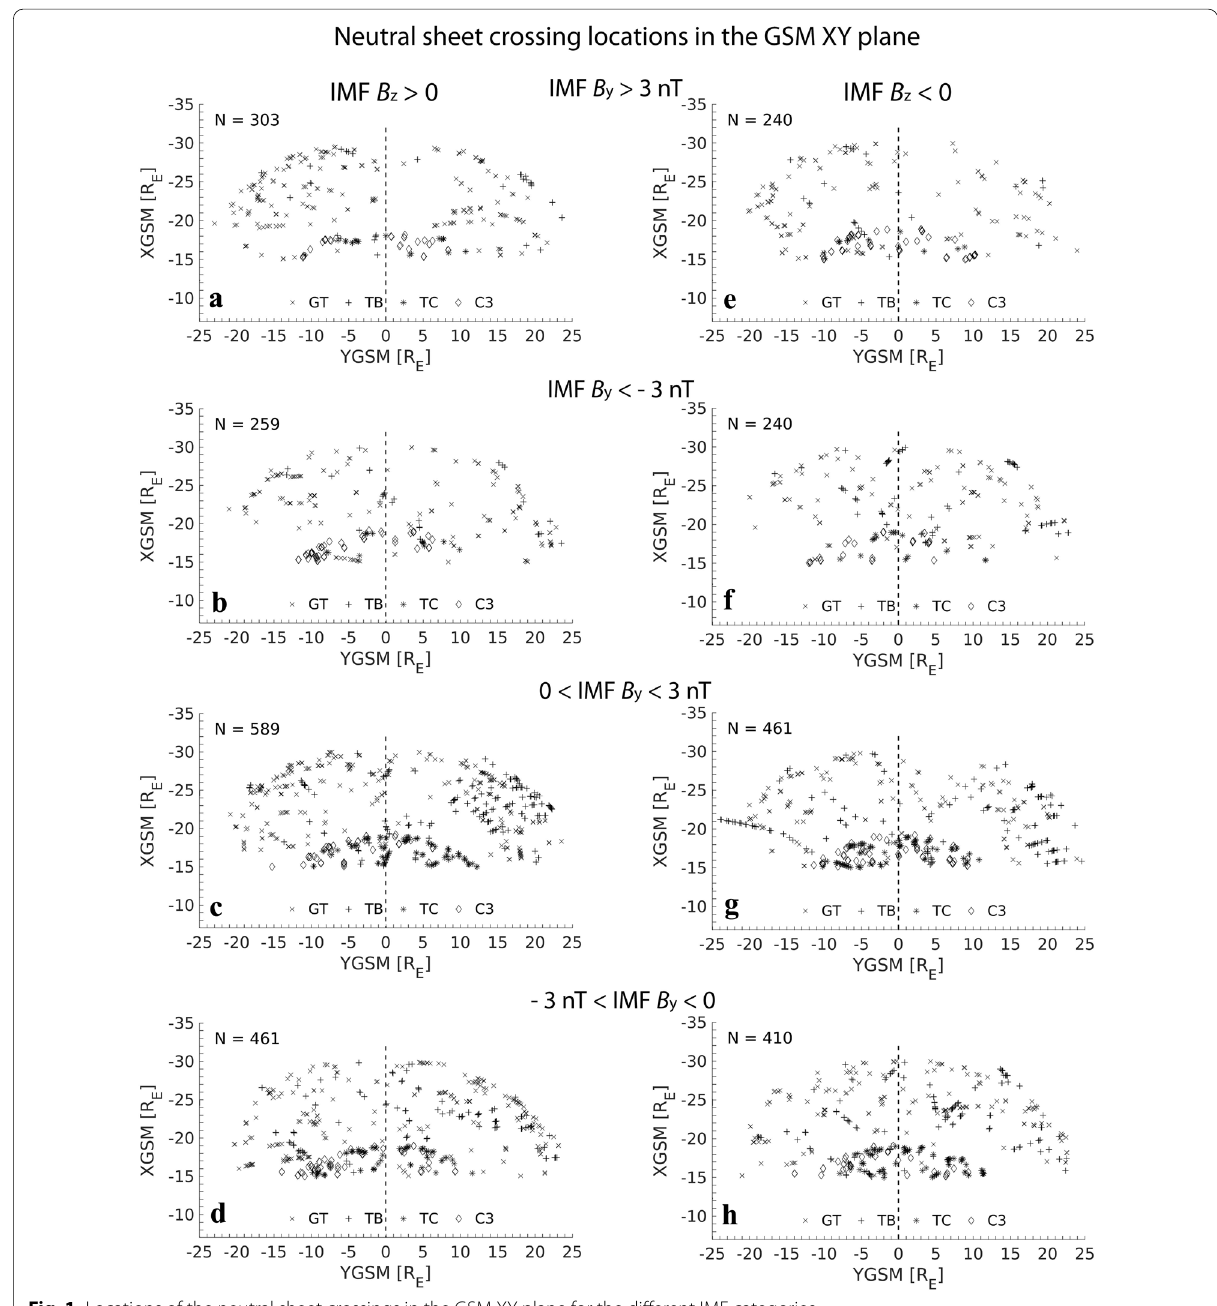
Fig. 1 Locations of the neutral sheet crossings in the GSM XY plane for the different IMF